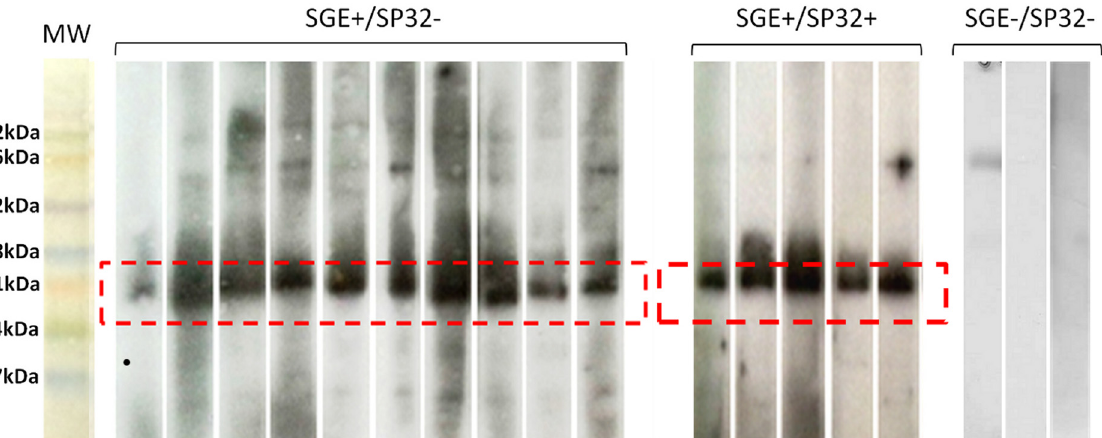
Fig 6. Western blot analysis of anti-rPpSP32 IgG antibodies. The recombinant form of PpSP32 was run on a 15% SDS-PAGE gel. Western blot analysis testing IgG antibodies against rPpSP32 was performed on three groups of randomly selected sera: 10 sera that were positive in an ELISA test for anti-SGE antibodies and negative for anti-SP32 antibodies (SGE+/SP32-), 20 concordant sera (SGE+/SP32+) and 10 negative samples (SGE-/SP32-). Representative sera are shown from each group. Dashed line delineates the bands corresponding to PpSP32. The RPN800E molecular weight (MW) marker (Amersham) was